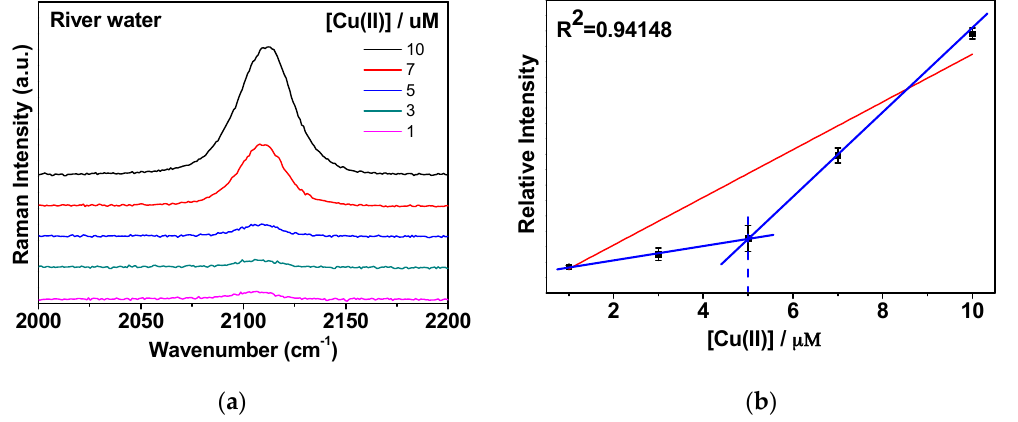
Figure 6. ( a ) A magnified view of the CN stretching region between 2000 and 2200 cm − 1 ; ( b ) Intensity plot fitting the linear region on the [Cu 2+ ] concentration range of 1–10 µM for river water. Three independent measurements were performed to yield the error bars.